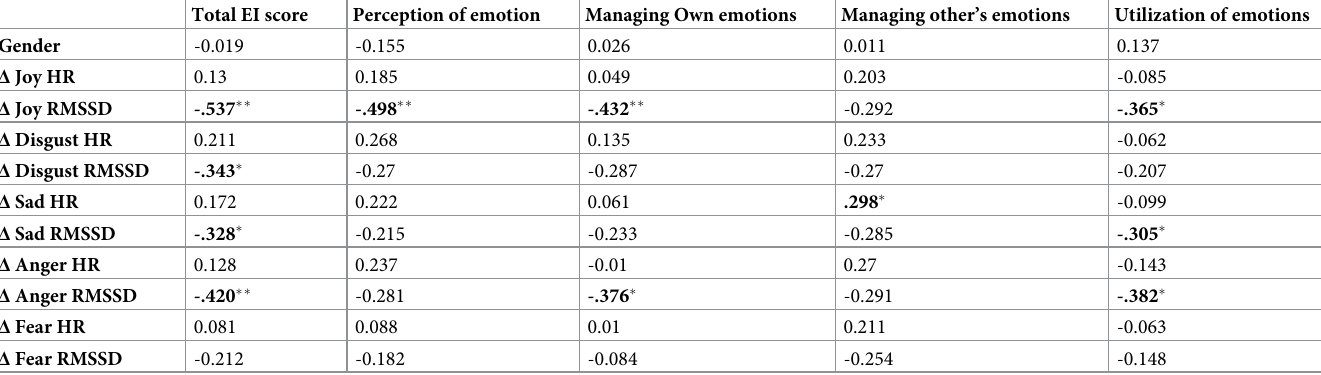
Table 11. Pearson correlations between cardiac reactivity parameters and emotional intelligence scores.